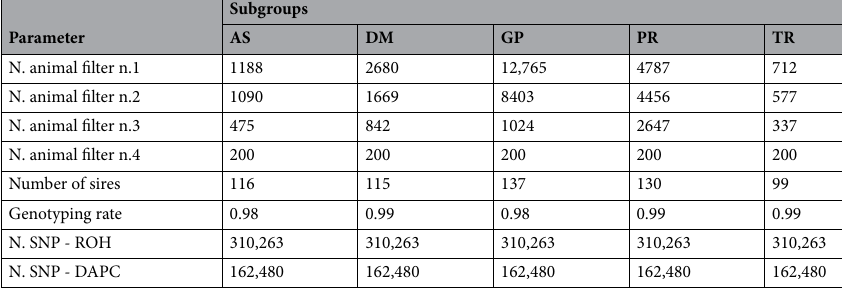
Table 1. Number of animals analyzed after the four filters applied for the selection of the animals, number of sires in each subgroup, genotype rate and number of SNP used for ROH and DAPC analyses per each subgroup. AS = Asiago; DM = Drinkable Milk; GP = Grana Padano; PR = Parmigiano Reggiano; TR =